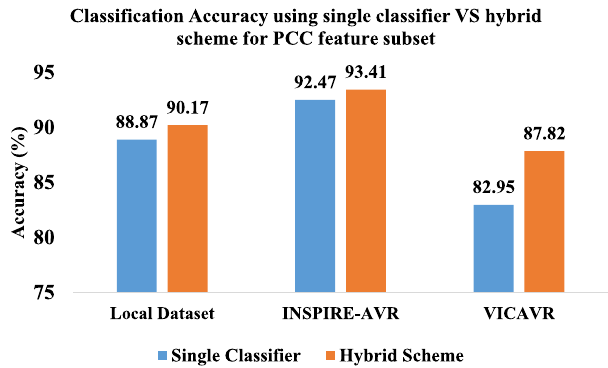
Fig. 19. Comparison of classi¯cation accuracy obtained using single classi¯er (shown in blue) and proposed hybrid classi¯- cation (shown in orange), for feature subset from PCC